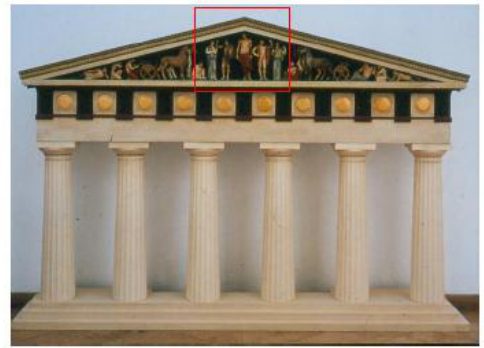
Figure 1. Reconstructed plaster model (approx. scale 1:10) of the east front of the temple of Zeus at Olympia.